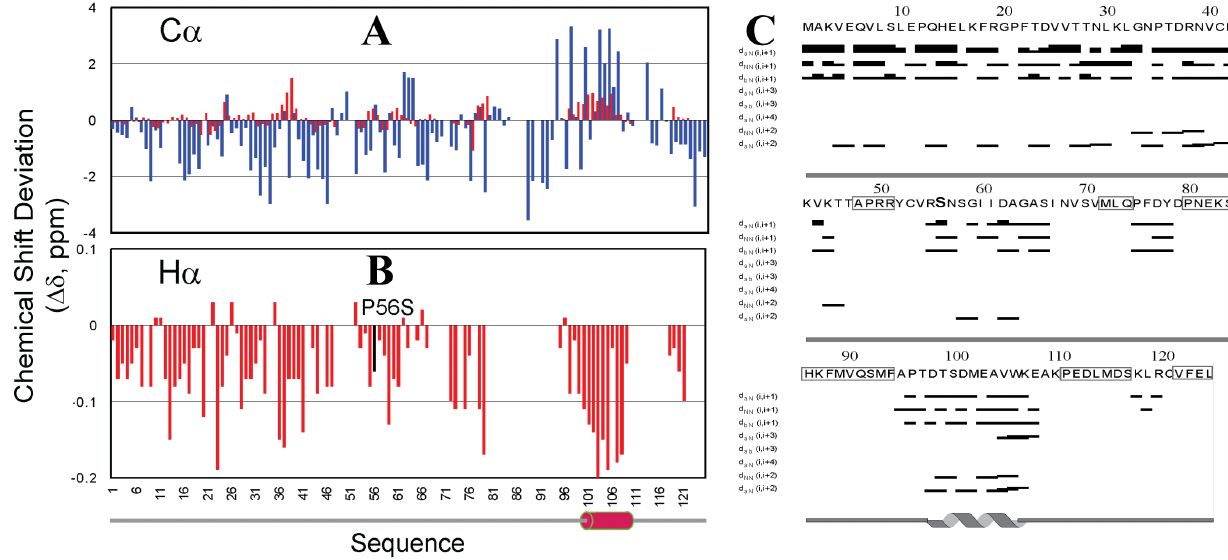
Figure 13. Residue-specific conformations of the P56S-MSP domain in unsalted water. ( A ) Bar plot of chemical shift deviations ( Δ δ = δ obs - δ coil) of C α atoms from their random-coil values for the wild-type (blue) and P56S (red). ( B ) Chemical shift deviations of H α atoms for P56S. ( C ) Characteristic NOEs defining secondary structure identified for the P56S